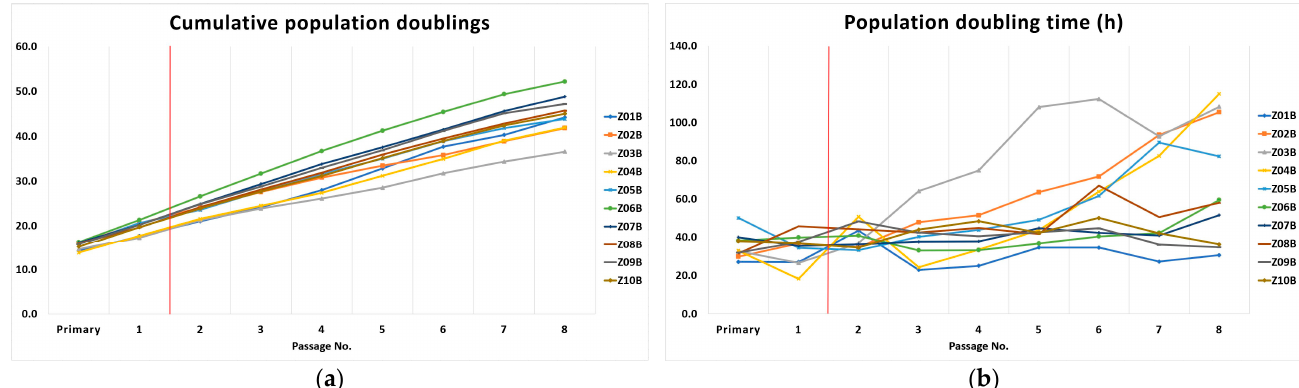
Figure 1. Kinetics of the Dental pulp stem cells (DPSCs). A red vertical line illustrates the time of DPSC cryopreservation in the p1: ( a ) Cumulative population doublings; ( b ) Population doubling time in hours.